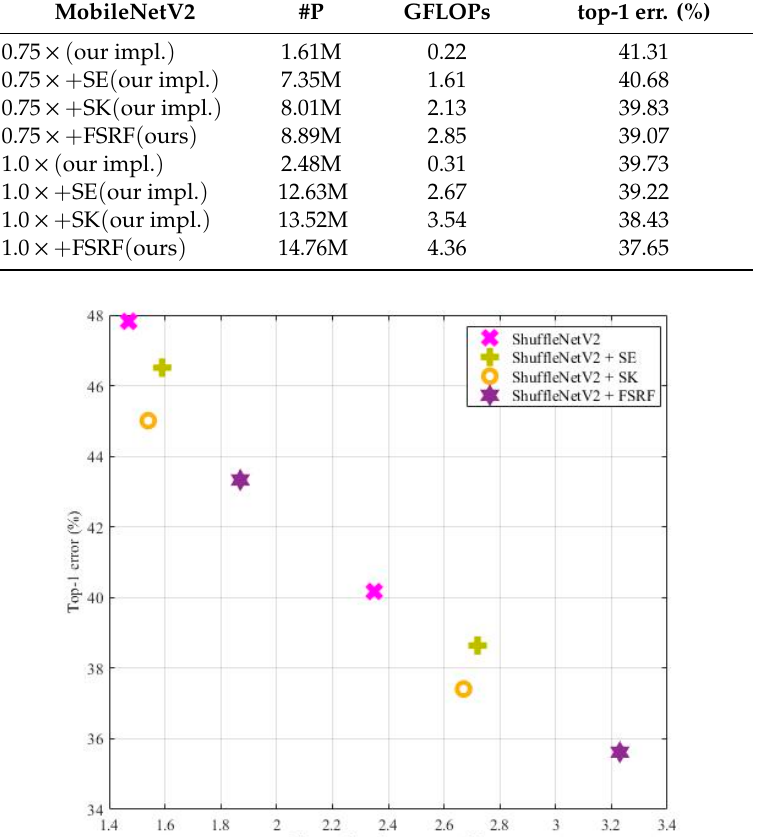
Table 4. Single 224 × 224 cropped top-1 error rates (%) on the Tiny ImageNet validation set and complexity comparisons, with all models based on the corresponding MobileNetV2. MobileNetV2